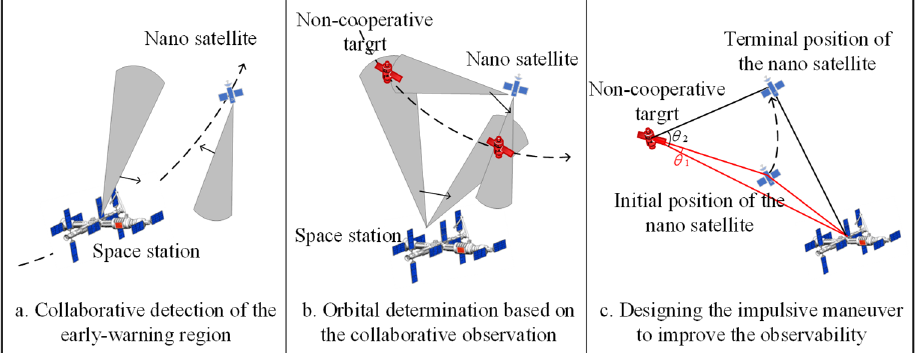
Figure 2. Diagram of mission